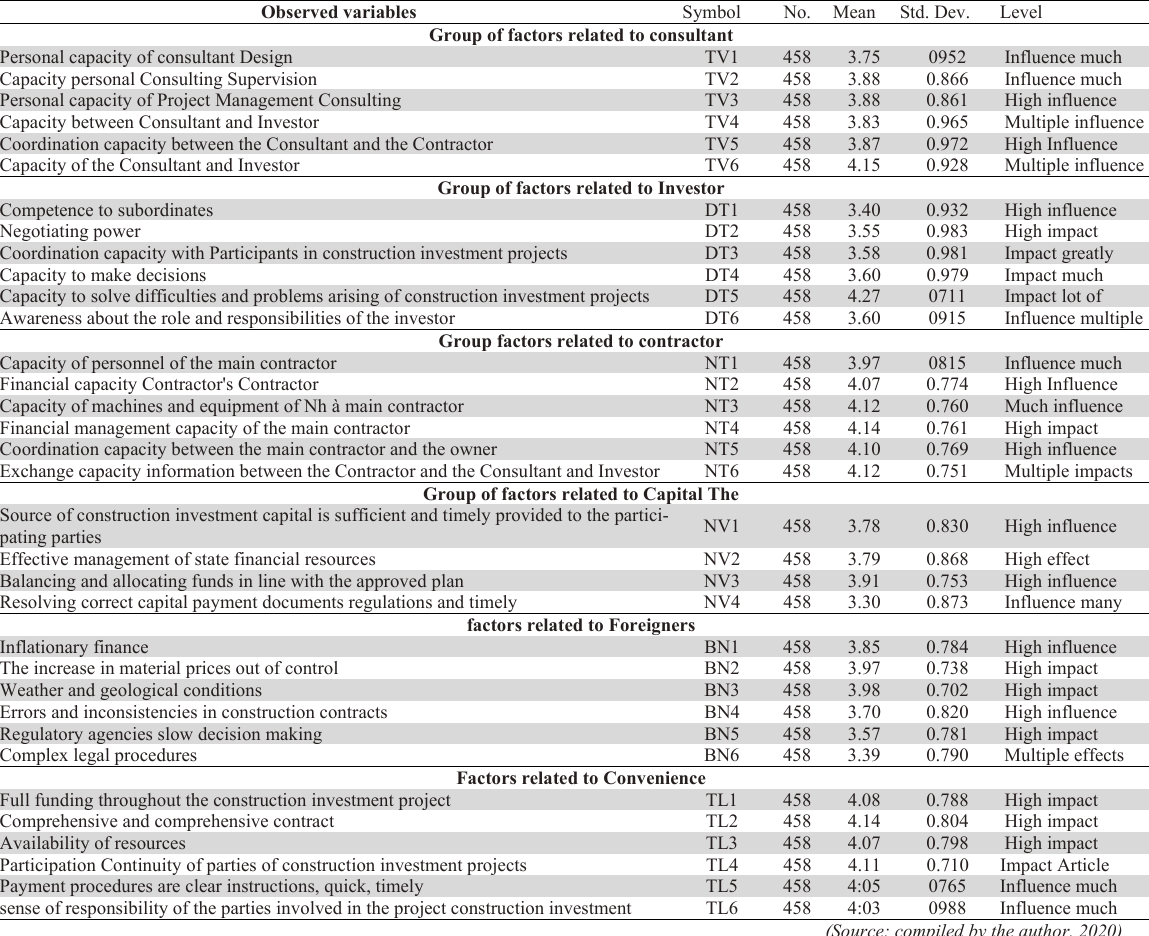
Assessing the influence of the scale of factors in the model Observed variables Symbol No. Mean Std.